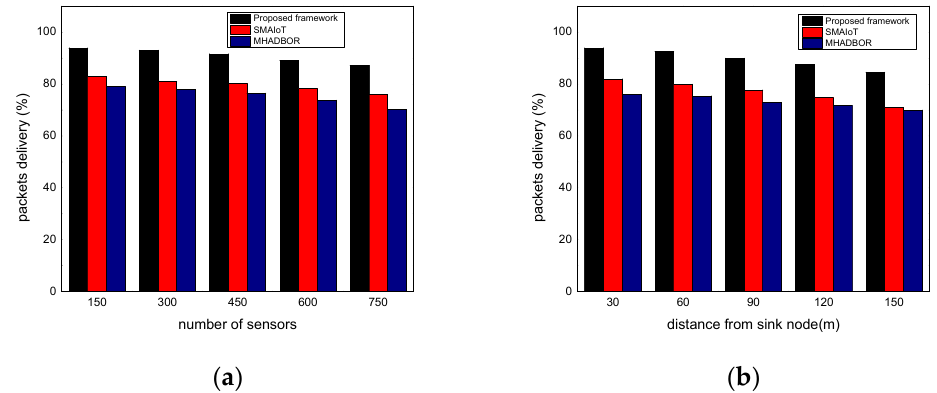
Figure 6. ( a ) Packets delivery with varying sensors and ( b ) Packets delivery with varying distance.